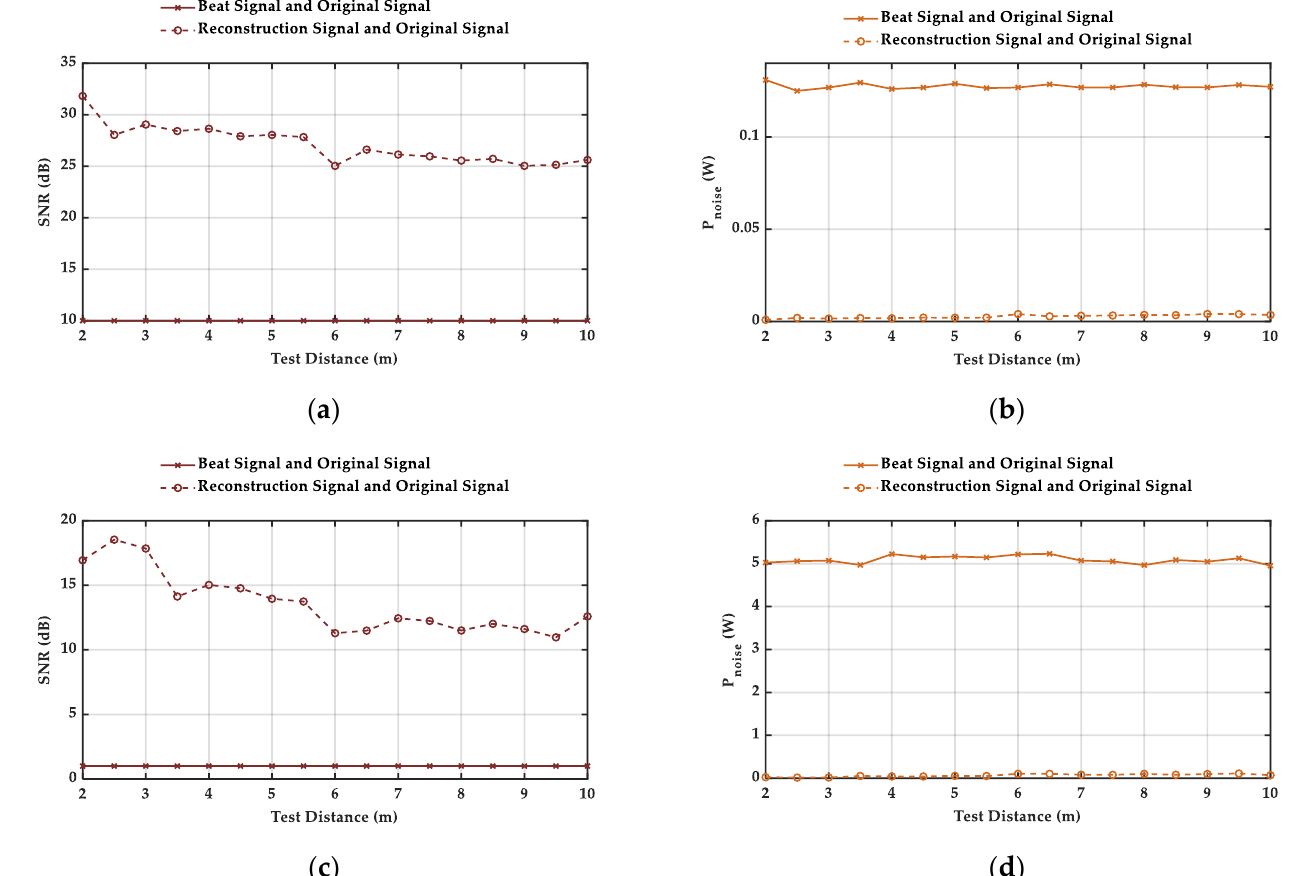
Figure 6. Simulation results of two parameters for evaluating signal comparison at different distances and noise powers. ( a , c ) are SNR , ( b , d ) are P noise . Additionally, the original SNR of WGN in ( a , b ) is 10 dB, and the original SNR of WGN in ( c , d ) is 1 dB .